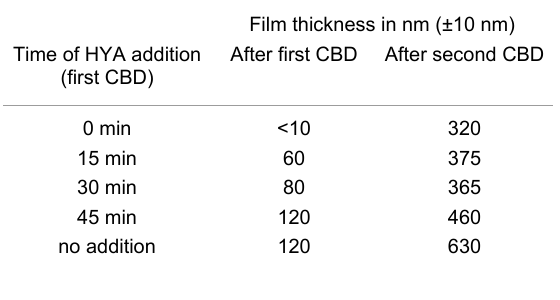
Table 1: Individual film thicknesses of ZnO films. The films were grown with different addition times of HYA during the first CBD or without HYA. The individual film thicknesses of the films grown in the first and in the subsequent CBD steps were deduced from cross section SEM micrographs.